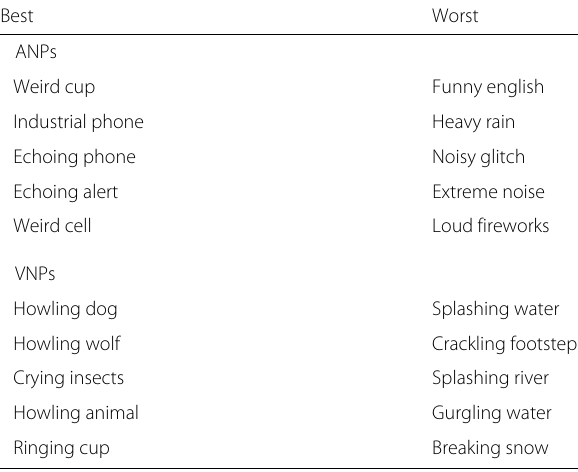
Table 5 Top five best and worst binary classified ANPs and